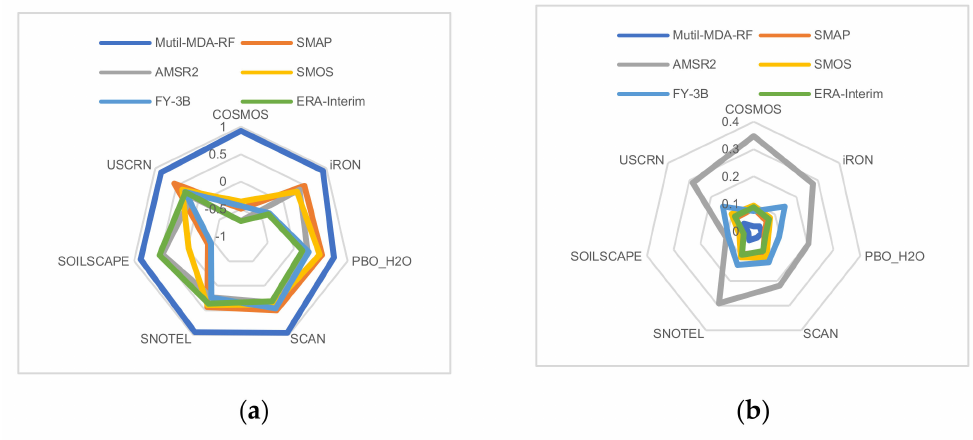
Figure 17. Radar plots for ( a ) R and ( b ) ubRMSE of six SM products at different networks.